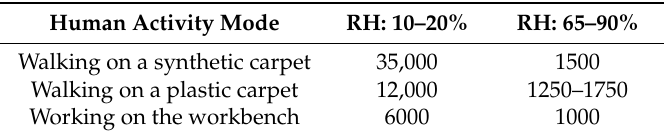
Table 1. Human body activity voltage (V)